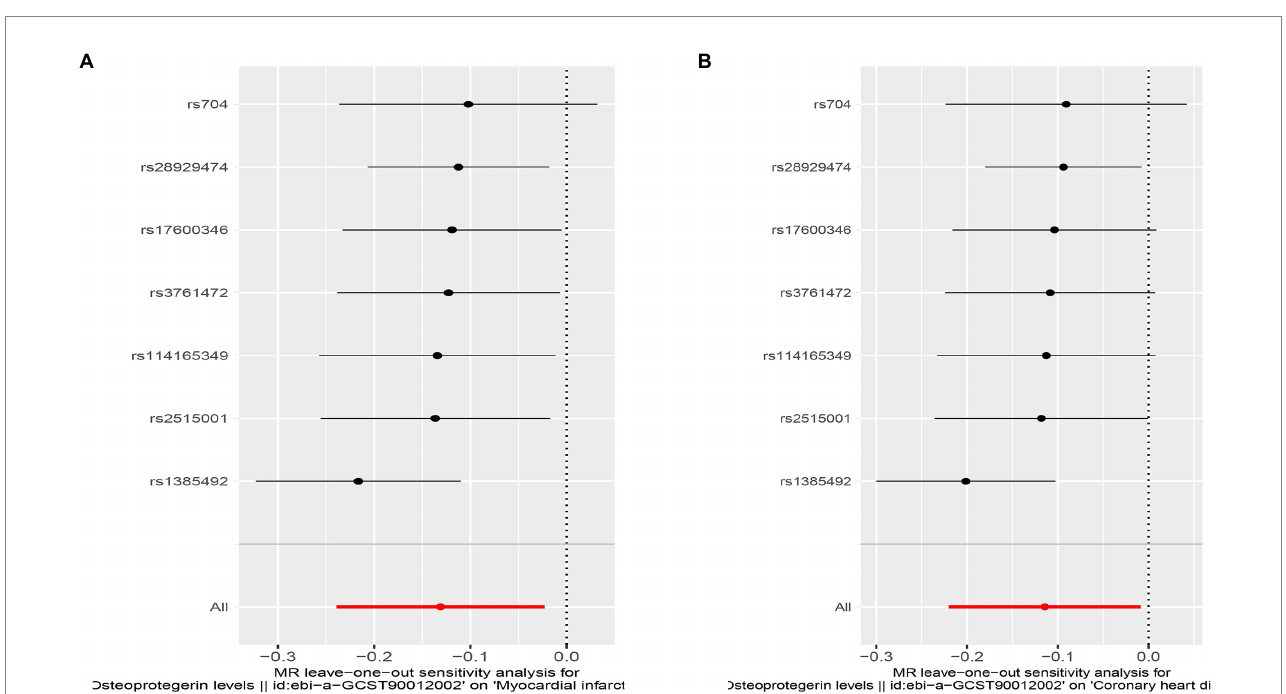
FIGURE 7 Sensitivity analyses using the leave-one-out approach for the association of plasma OPG level with outcomes. (A) AMI; (B) CHD.